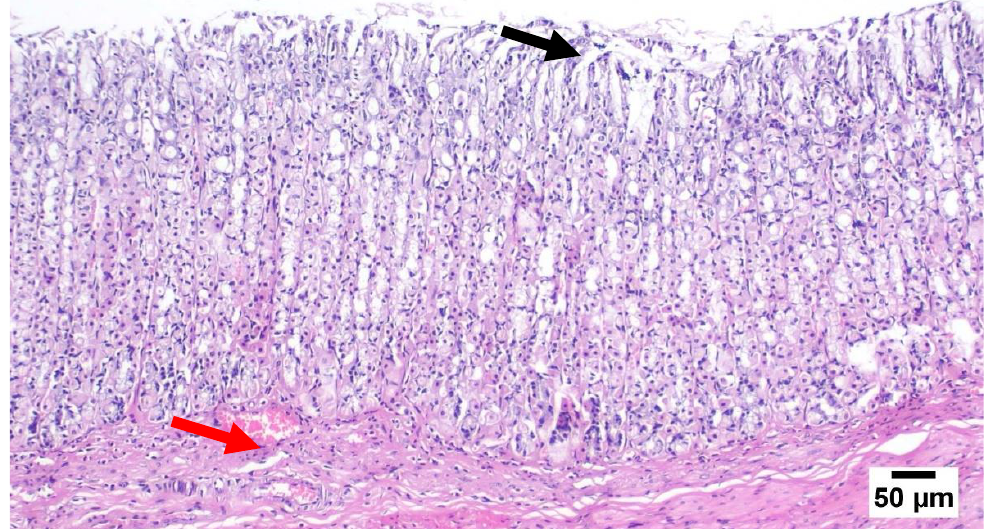
Figure 17. Photomicrograph of stomach, G3-D9-Asp showing mild epithelial loss (black loss), congestion (red arrow), and mild inflammatory reaction (H&E).